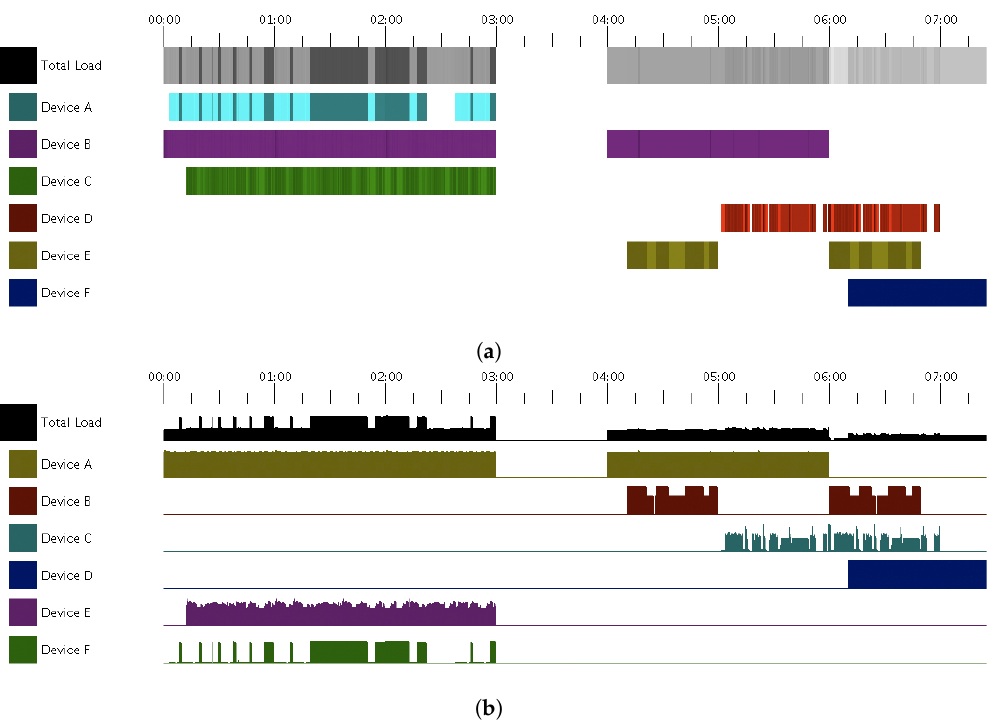
Figure 8. Example of a time-tone visualization ( a ) and its corresponding area chart ( b ), showing variations in energy usage load by each individual device, as well as the total, over time. Images from Reference [41].